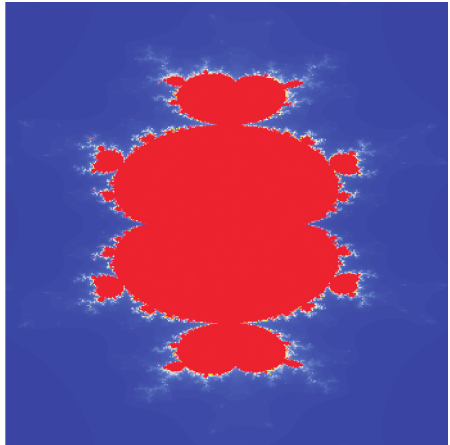
Figure 21: Cubic Mandelbrot set in JSOmhh.